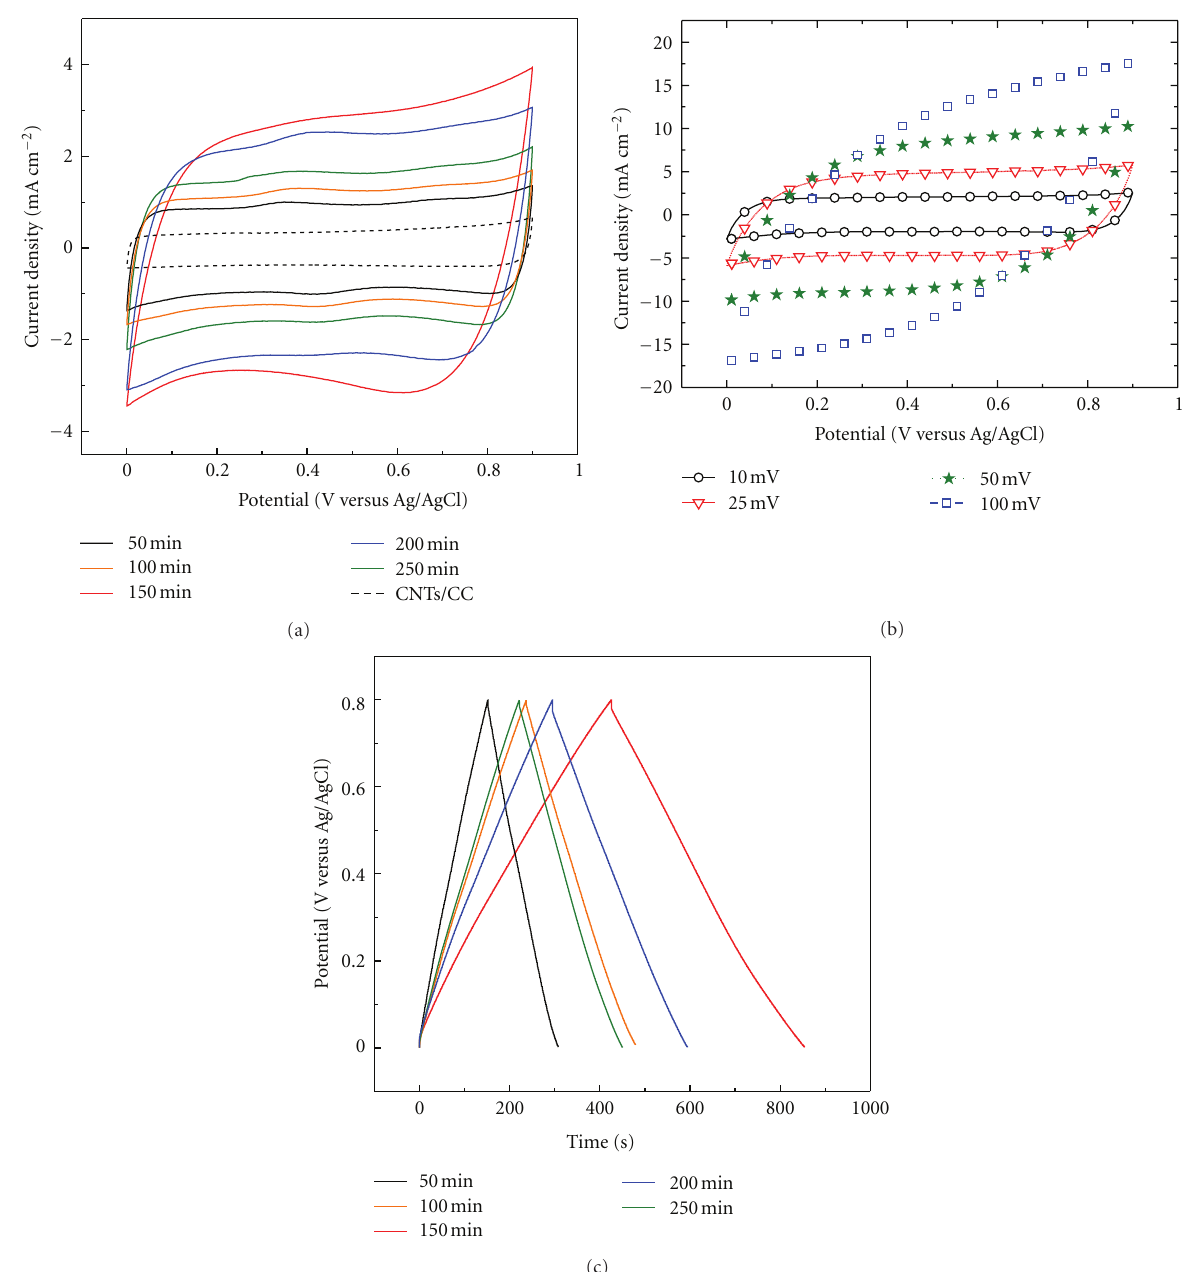
Figure 7: (a) Cyclic voltammograms of MnO 2 /CNxNTs/CC hybrid electrodes with di ff erent deposition times at a scan rate of 10mV/s; (b) cyclic voltammograms of the hybrid electrode under di ff erent scan rate of 10 mVs − 1 , 25 mVs − 1 , 50mVs − 1 , and 100mVs − 1 . (c) Galvonastatic charge-discharge curves of MnO 2 /CNxNTs/CC hybrid electrodes with di ff erent deposition times at a fixed current density of 1.32 A/g.